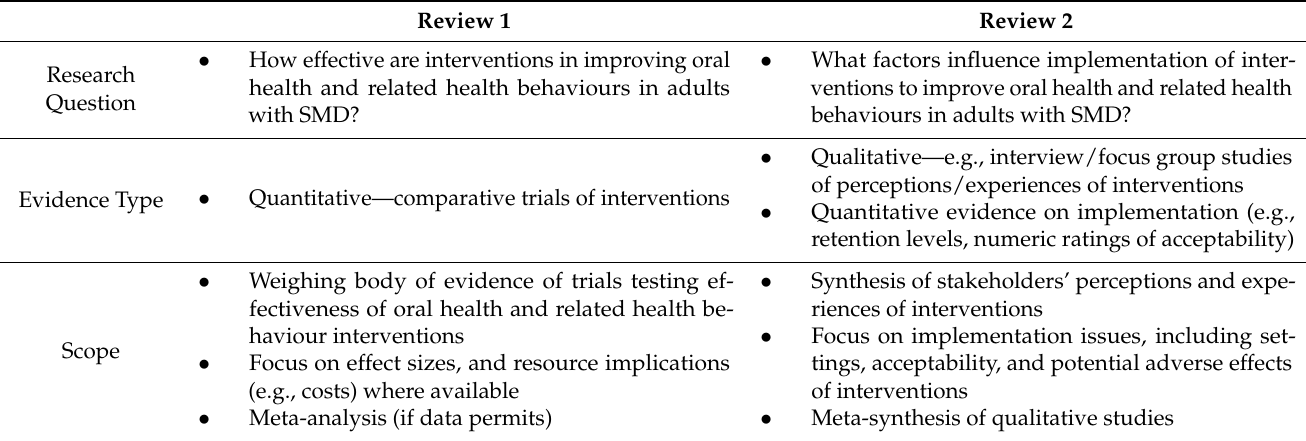
Table 1. Overview of the two